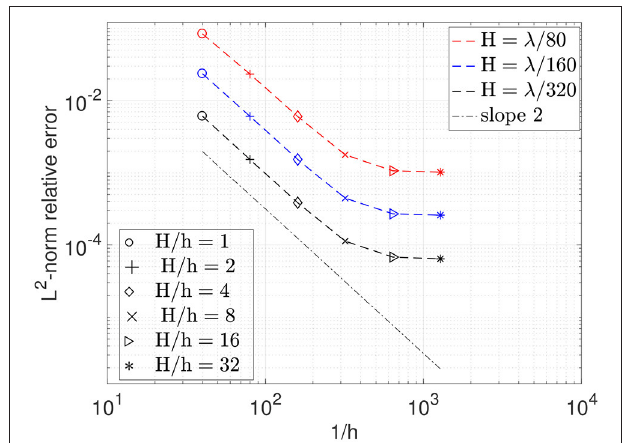
FIGURE 5 | The L 2 -norm relative error of the global numerical solution of the electric field E Hh to the exact electric field E , || E Hh − E || L 2 / || E || L 2 , as function of the fine and the coarse spatial step, h and H , respectively. The refinement level of the coarse grid varies between three values: H = λ/ 80, λ/ 160, λ/ 320. Concerning the patch, the refinement level varies from H / h = 1 to H / h = 32. The computational domain and the patch size are the same of the case in Figure 4 .